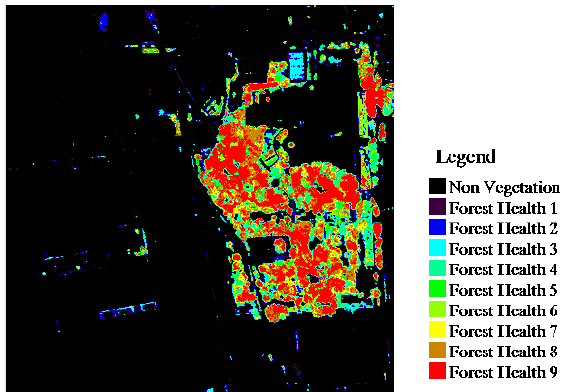
Fig. 10 Forest health index analysis of fused urban